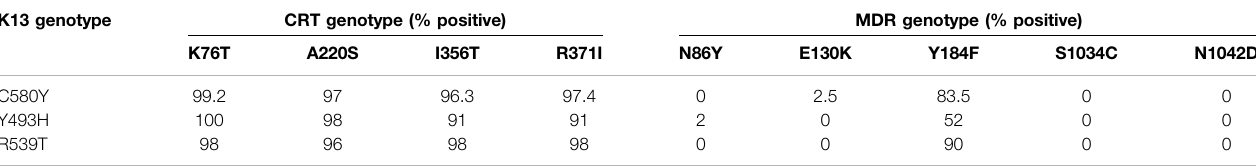
TABLE 1 | Co-prevalence of the K13 mutations with other markers of multidrug resistance. K13